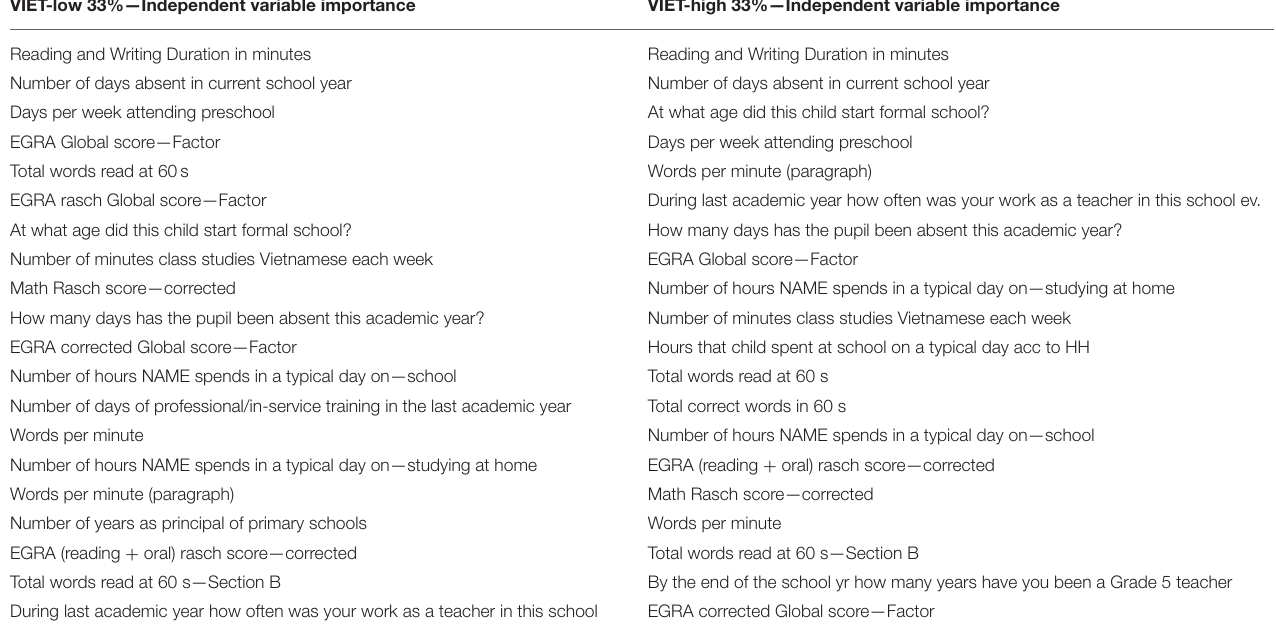
TABLE 6 | Top 20 variables by predictive weight for vietnamese performance levels. VIET-low 33%—Independent variable